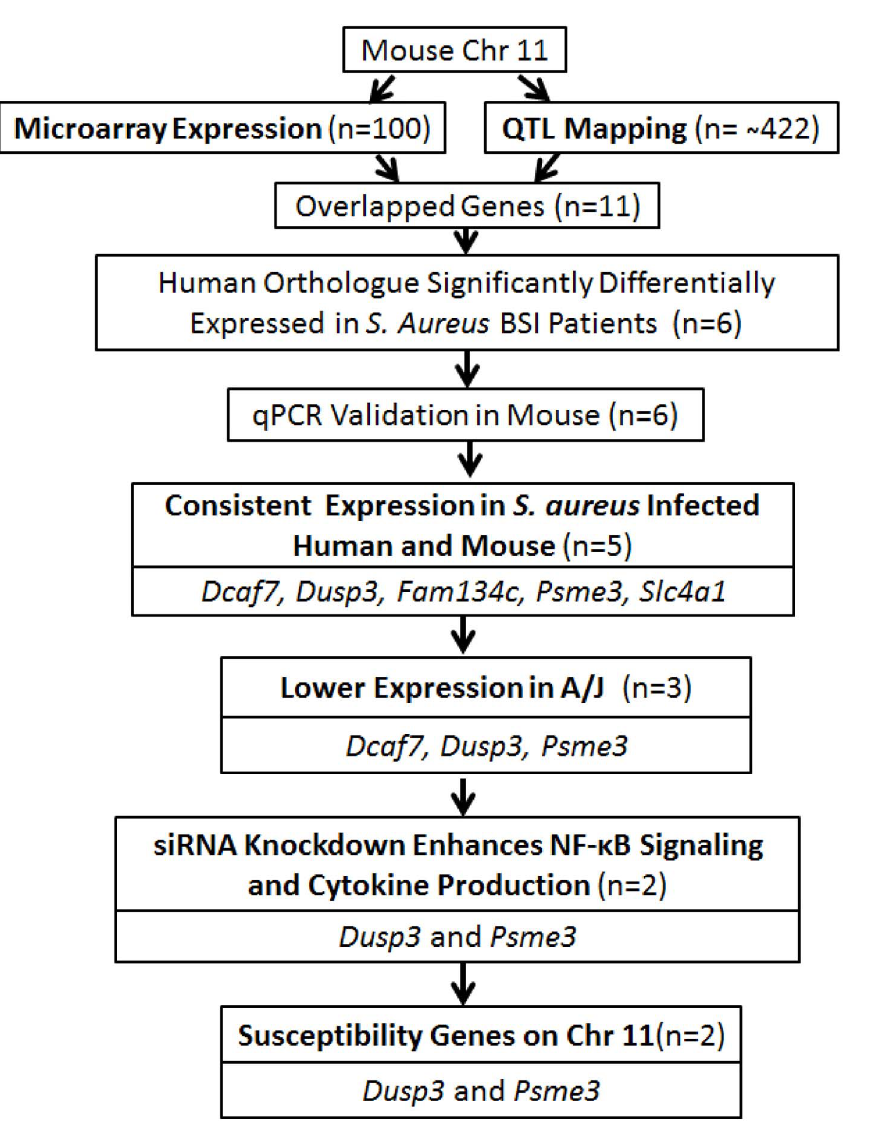
Figure 2. Overall strategy for identifying genes associated with S.aureus susceptibility on chromosome 11 of A/J mice. Flow chart of the strategy for identifying S. aureus susceptible genes on chromosome 11 of A/J mice. (Figure 4A), siRNA-mediated knockdown mimicked the status of susceptible A/J in RAW264.7 murine macrophages. These results suggest that lower expression of Dusp3 and Psme3 in A/J mice could explain the observed susceptibility to S. aureus .